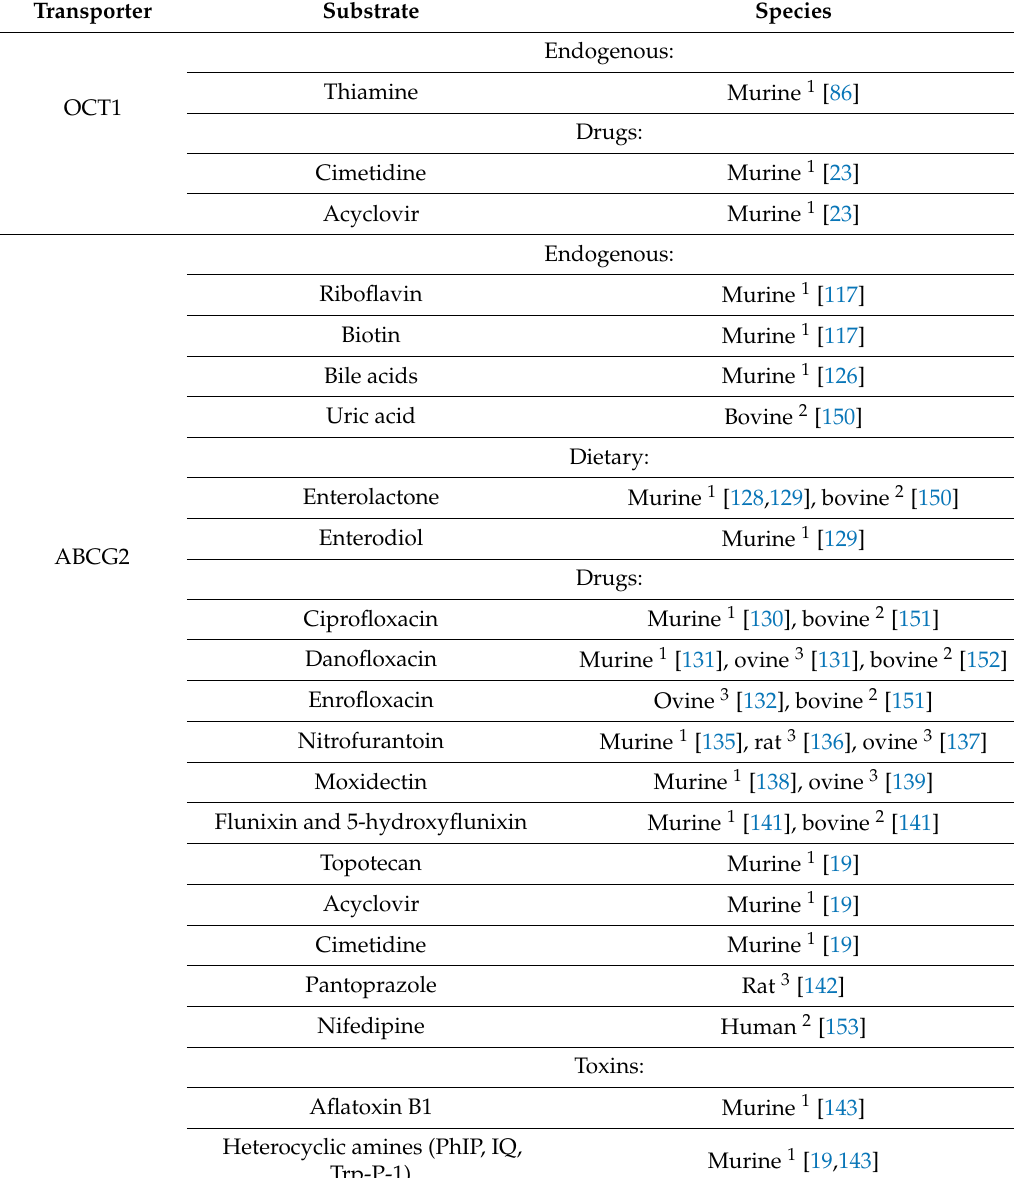
Table 1. Milk transfer of SLC and ABC substrates confirmed in